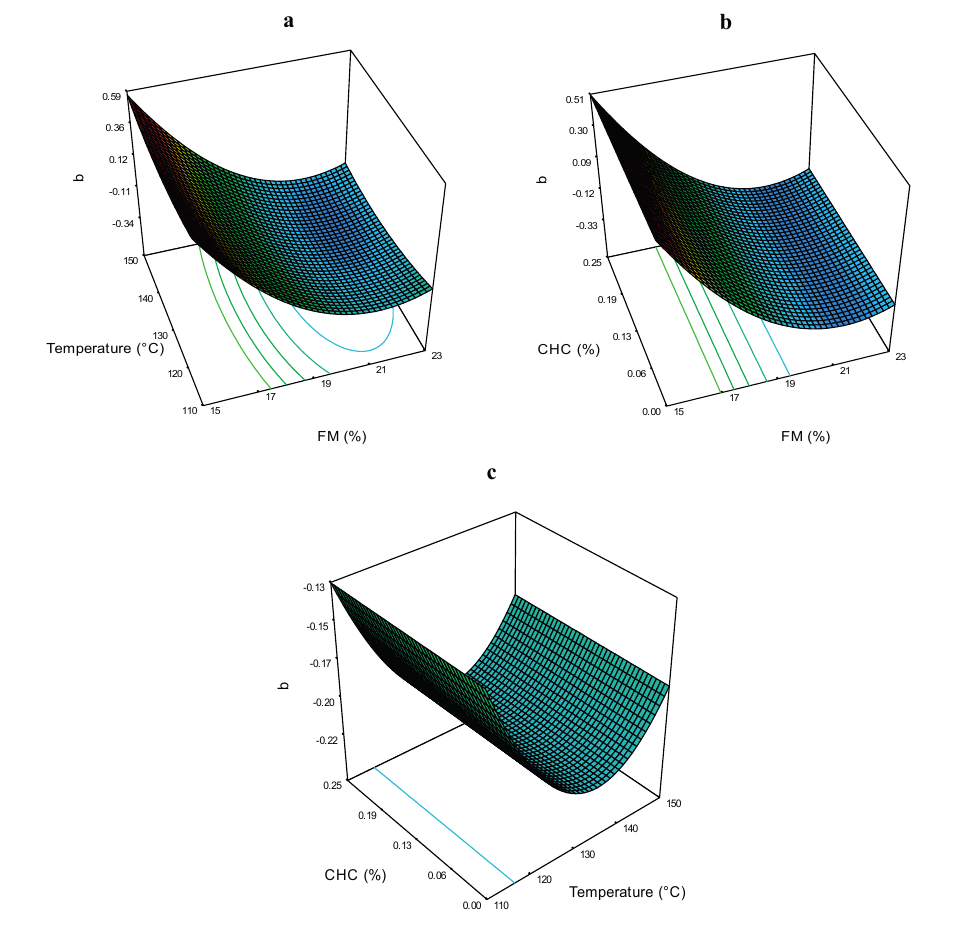
Figure 5 . Color parameter b of expanded nixtamalized blue corn extrudates, as a function of: ( a ) feed moisture (FM) and temperature (T); ( b ) feed moisture (FM) and calcium hydroxide concentration (CHC); and ( c ) temperature (T) and calcium hydroxide concentration